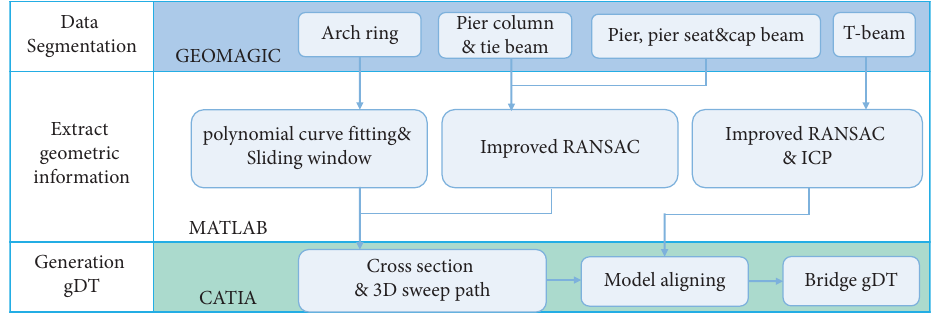
Figure 1: Overview of the proposed method for arch bridge gDT